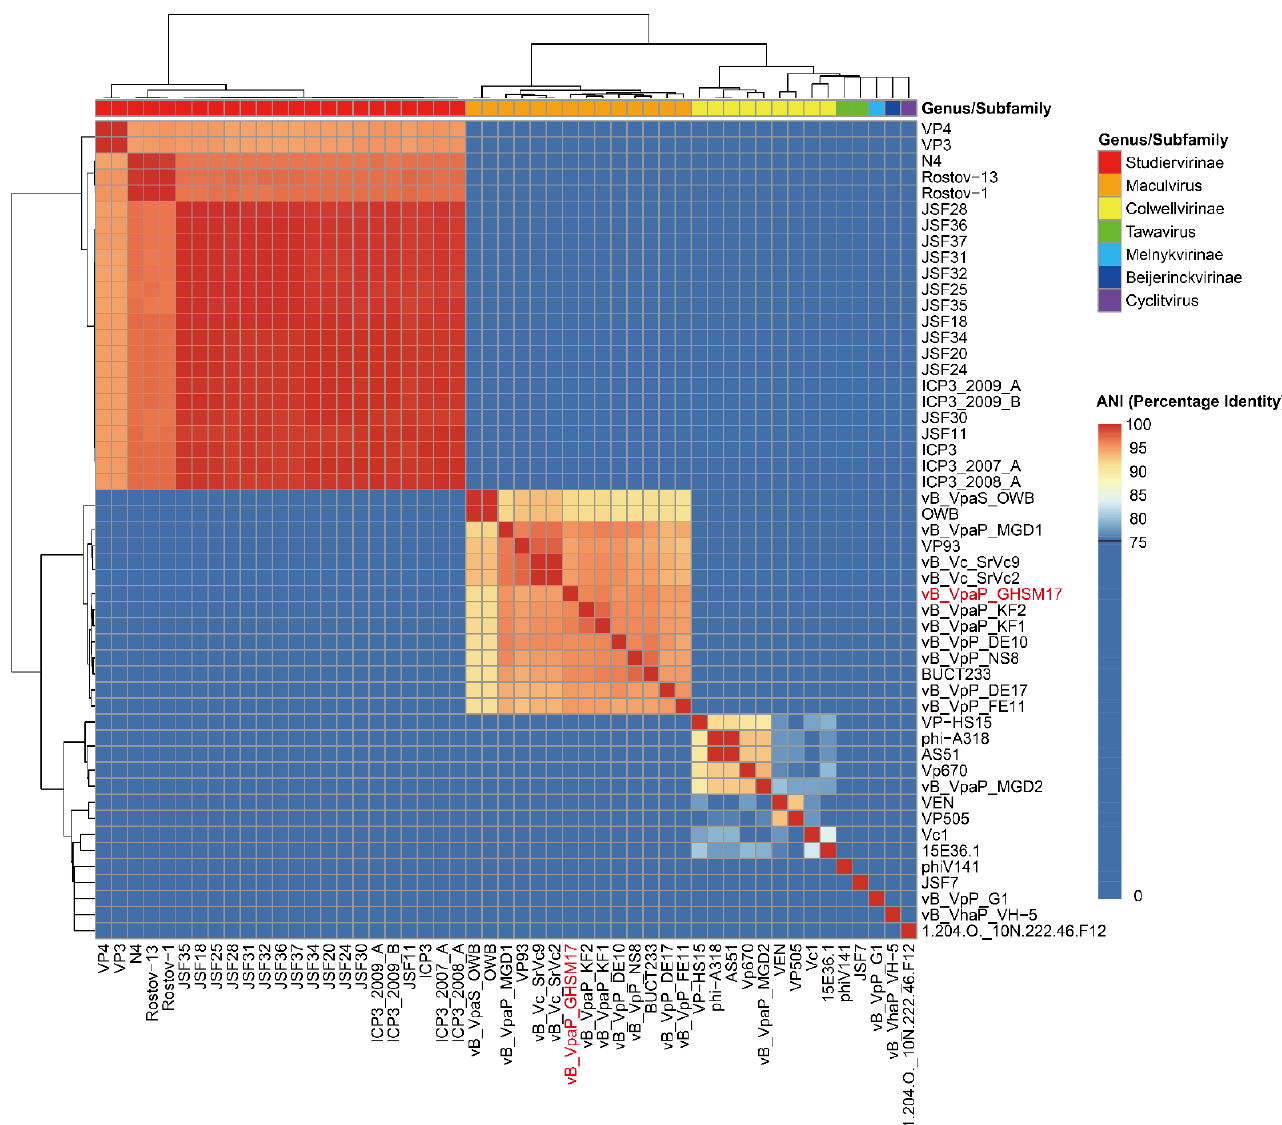
Figure 6. Heatmap of ANIm for 51 Vibrio phages. Values range from 0 (0%, navy blue) to 1 (100%,